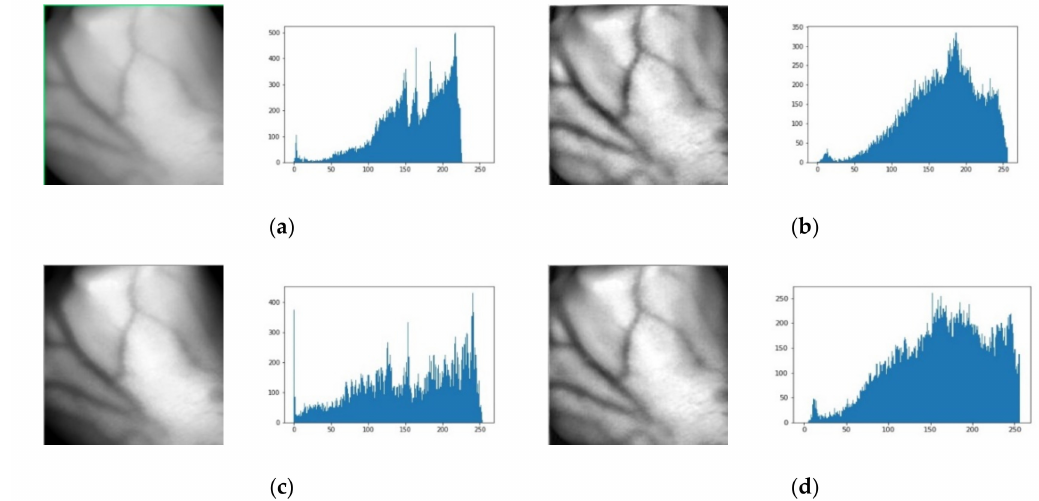
Figure 6. Results of each step of the proposed method with its corresponding histograms for a self-acquisition database. ( a ) Original bright contrast image. ( b ) After applying CLAHE. ( c ) After applying FAG. ( d ) CLAHE and FAG after applying improved weighted average